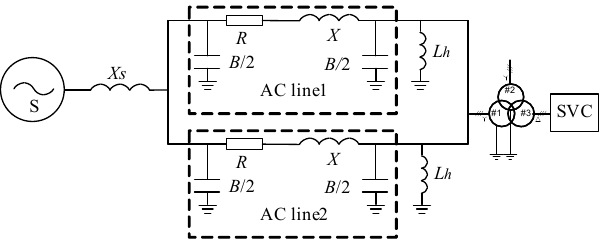
Figure 4. Simplified transmission system with SVC.